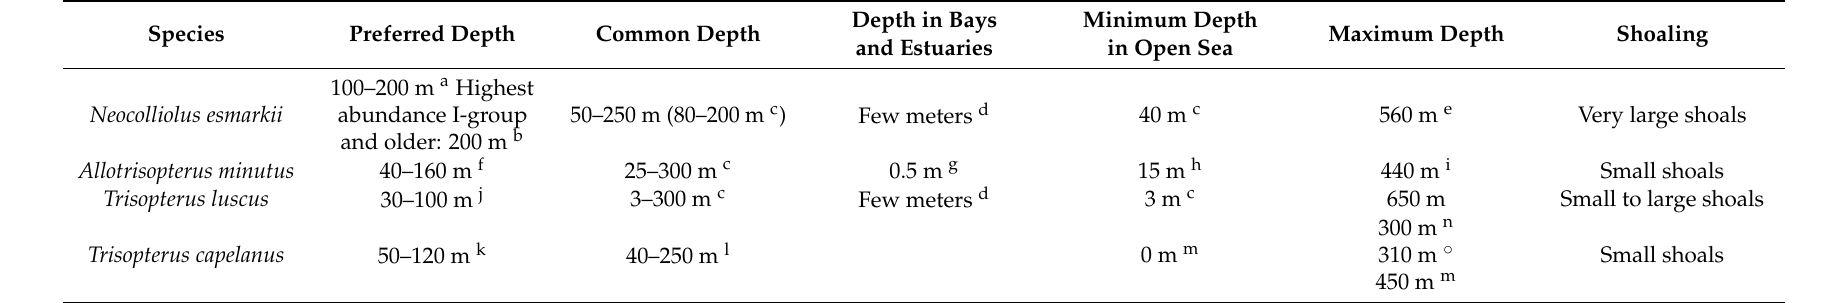
Table 2. Synopsis of depth distribution and schooling characteristics of recent trisopterine